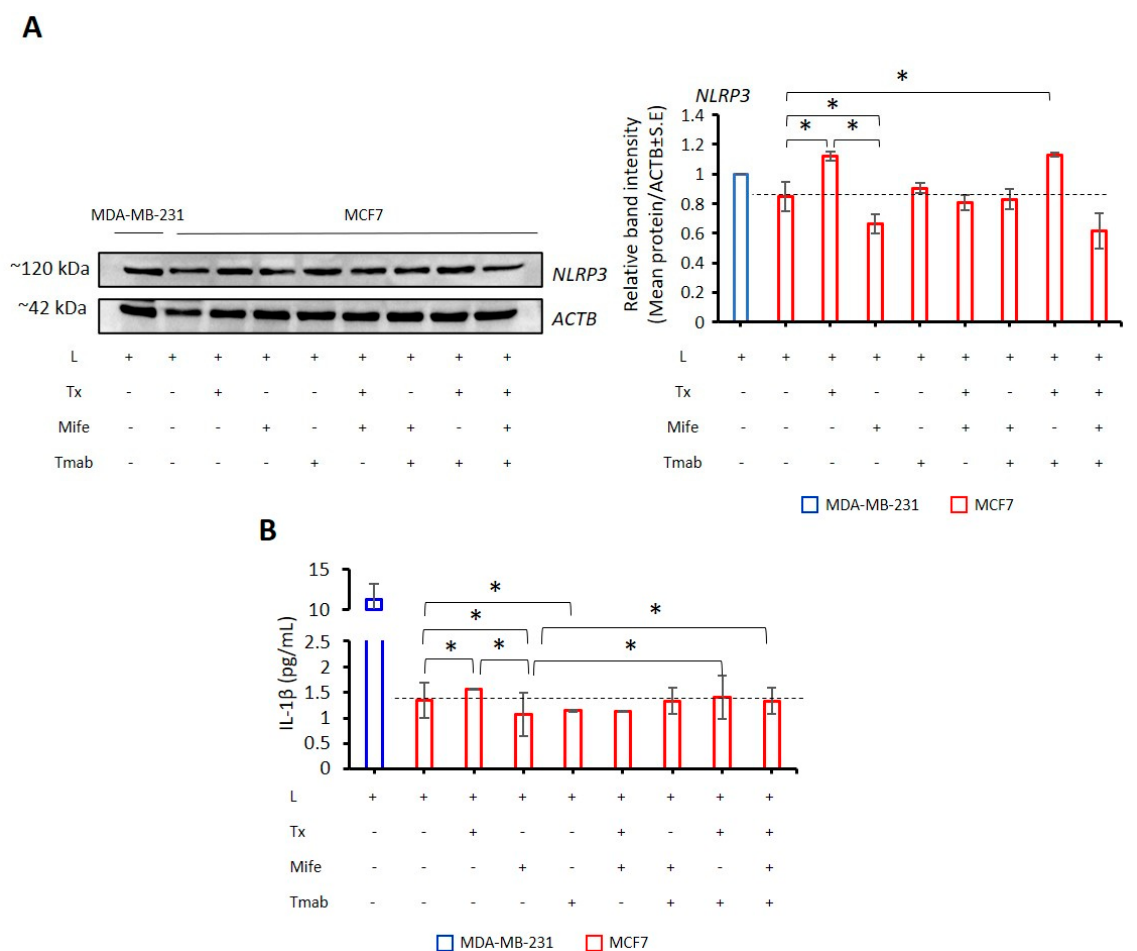
Figure 7. Effect of Tx, mife, and Tmab on NLRP3 expression in MCF ‐ 7 cells. LPS (1 μ g/mL; 3 h) was used to prime NLRP3 transcription and translation in MCF ‐ 7 cells. Tx (5 μ M; 24 h), mife (10 nM; 48 h), and Tmab (10 μ g/mL; 48 h) were added 3 h after LPS treatment. For positive control of NLRP3 inflammasome activation, MDA ‐ MB ‐ 231 cells were primed LPS. ( A ) Western blot analysis of NLRP3 protein expression in MCF7 cells. Data represent two technical repeats. ( B ) ELISA detection of IL-1